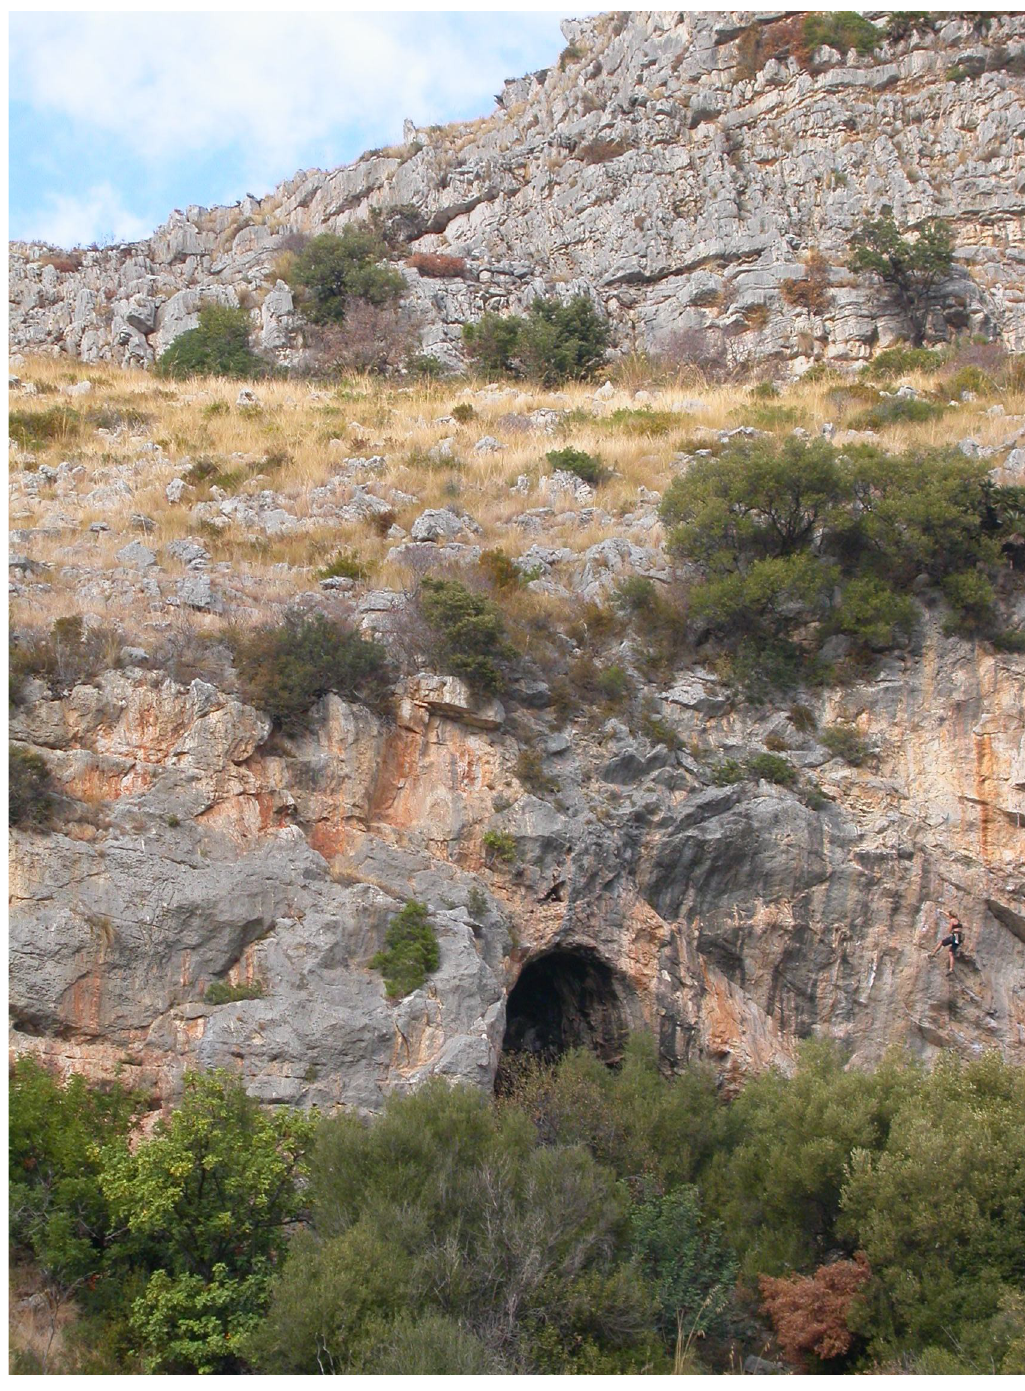
Fig 5. View of Grotta di